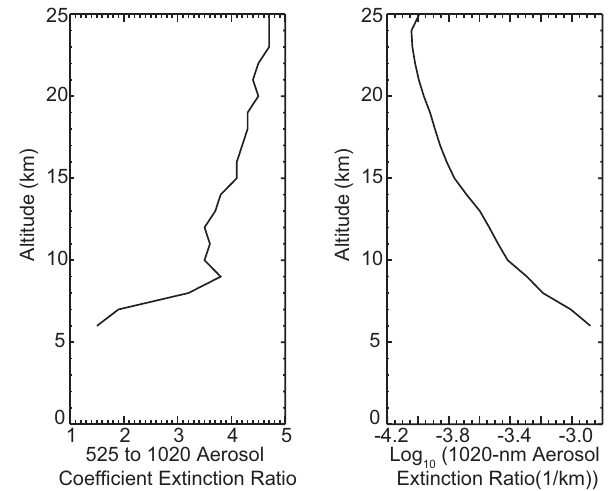
Fig. 7. The vertical profiles of aerosol coefficient extinction ratio centroid, R a , (left) and the extinction coefficient value for the sep- aration of primary aerosol from enhanced aerosol and clouds, k o , (right) for DJF between 1999 through